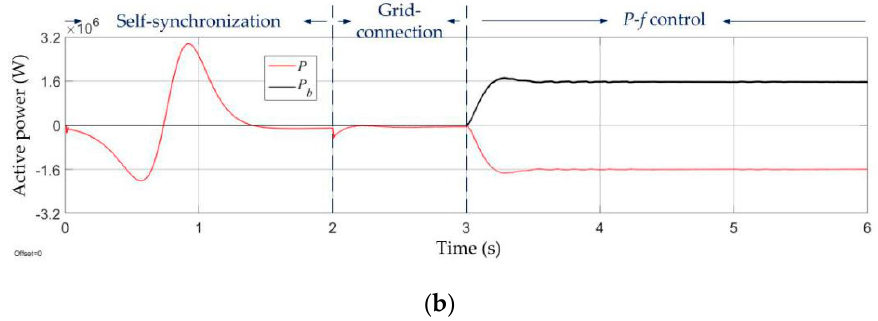
Figure 18. Dynamic response of the energy storage module to variation of the grid frequency: ( a ) the grid frequency f g and the system output frequency f ; and ( b ) the energy storage module active power P b and the system output active power P .